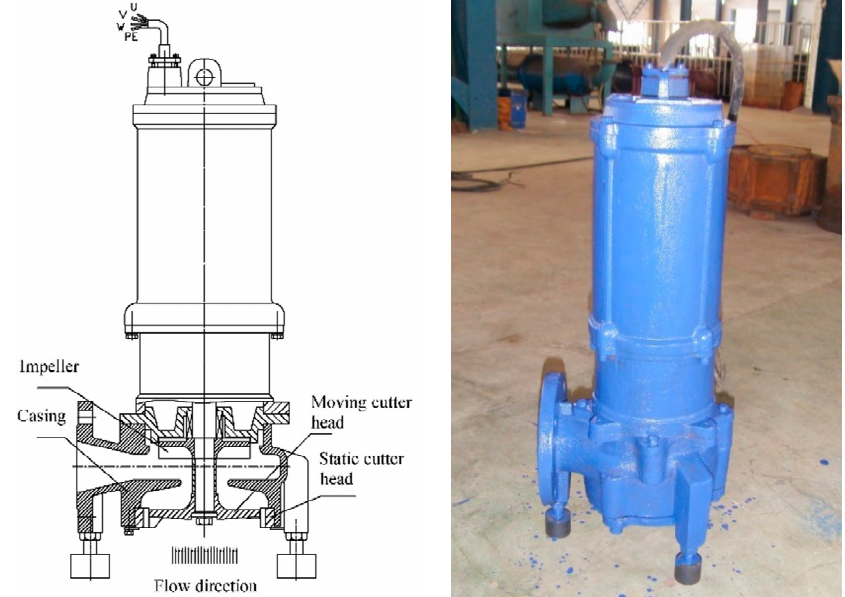
Figure 5. Non-jammed submersible grinder pump.